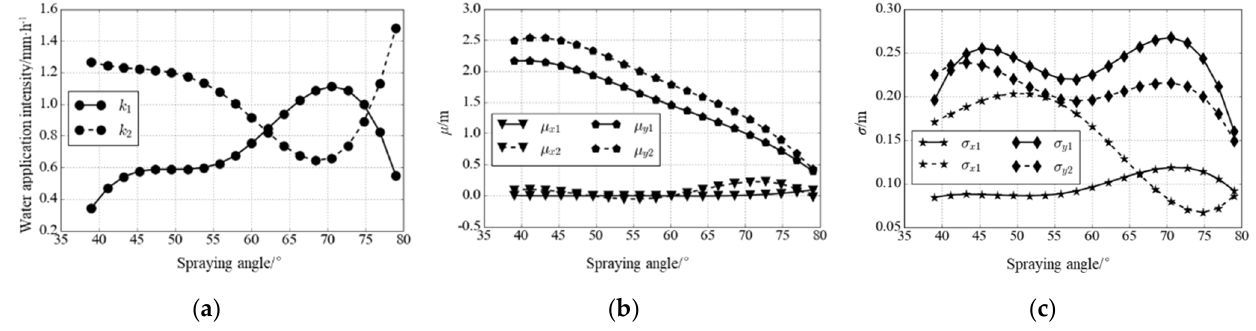
Figure 12. Effect for different spraying angles on fitting parameters of water application intensity at 41 kPa: ( a ) k and peak value; ( b ) µ x and µ y and ( c ) σ x and σ y . Notes: k 1 and k 2 were used to quantify the effect of the two unimodal peaks on the bimodal distribution. µ x 1 and µ x 2 are the peak locations near and far away from an individual orifice in x direction. µ y 1 and µ y 2 are the peak locations near and far away from an individual orifice in y direction. σ x 1 and σ x 2 are the dispersion degrees of water distribution near and far away from an individual orifice in x direction; σ y 1 and σ y 2 are the dispersion degrees of water distribution near and far away from an individual orifice in y